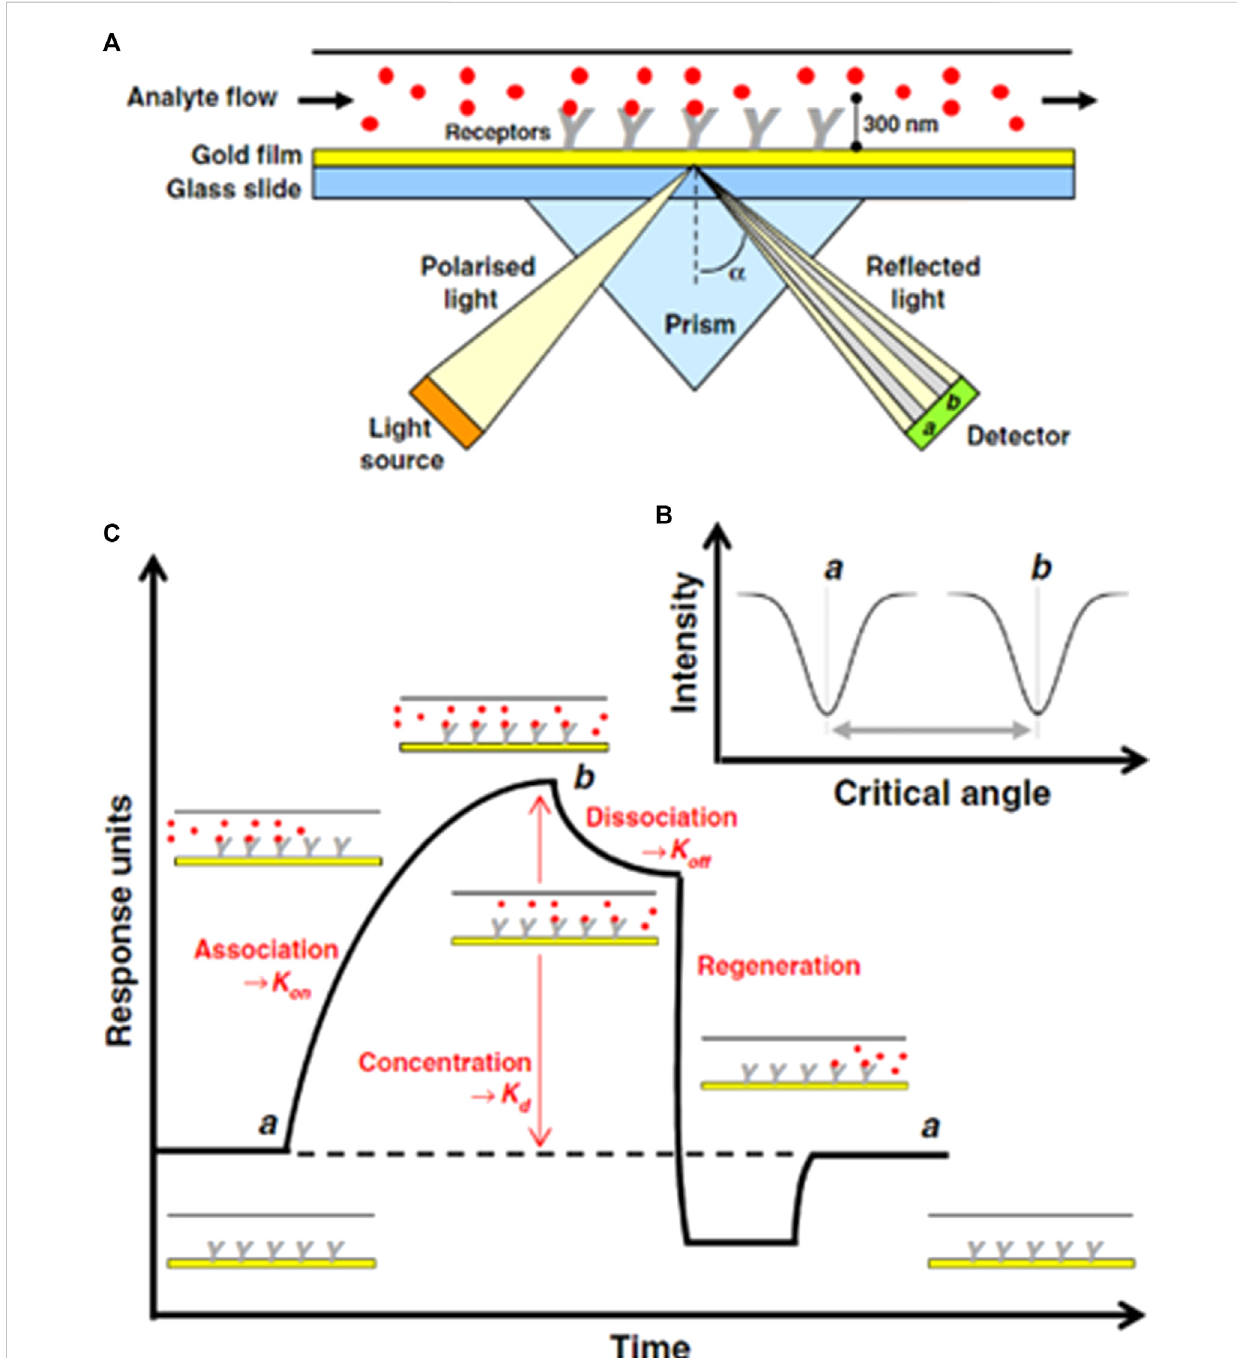
FIGURE 5 (A) Schematic of SPR-based DNA sensing technique for measuring the binding of an analyte molecule (B) varation in critical angle as fuction of intensity of incident light, (C) Evolution of sonogram's response during SPR experiment (Patching,